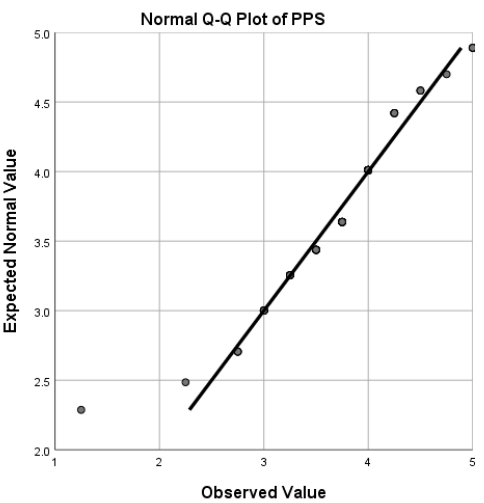
Figure 3. Quantile-quantile (Q-Q) plot for distribution of PPS scores.